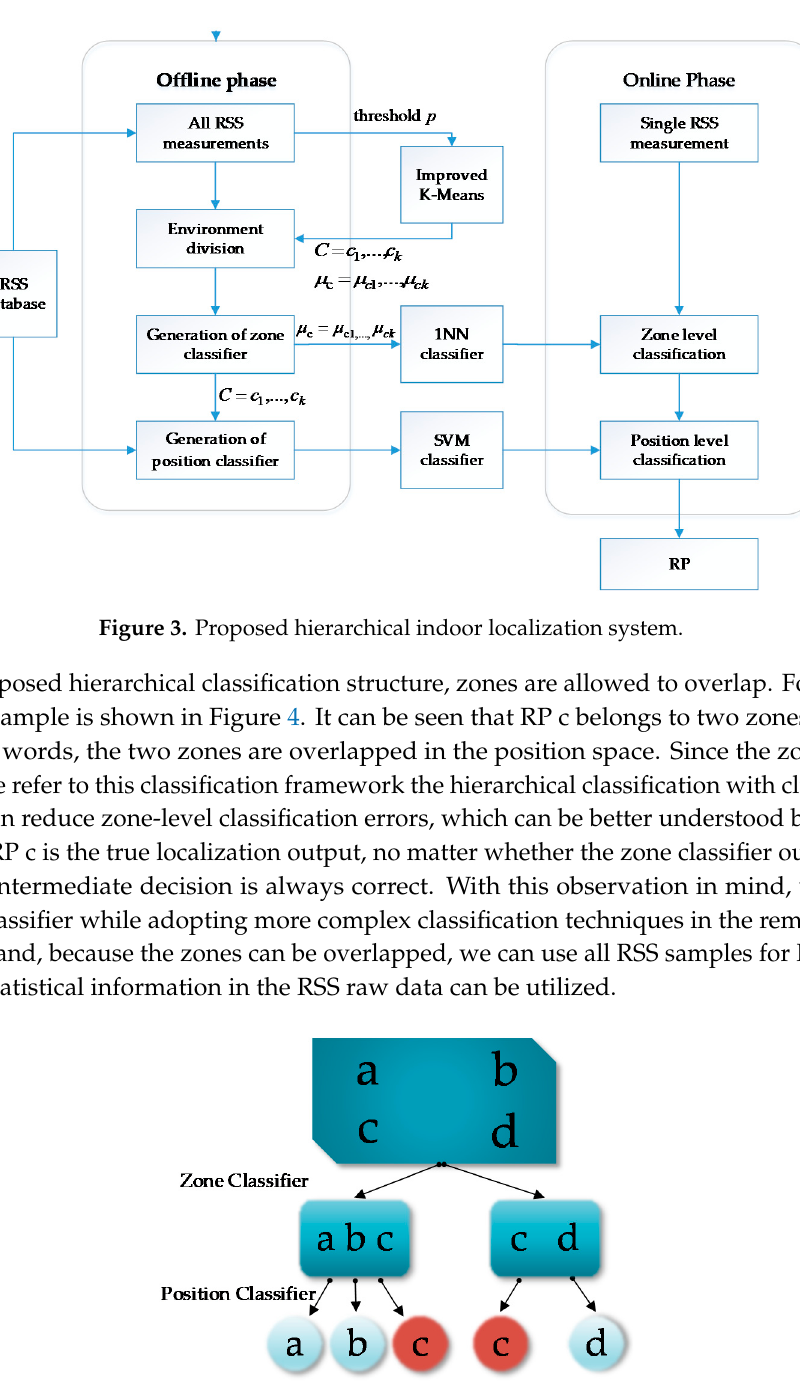
Figure 4. Hierarchical classification-based indoor positioning with zone overlap.